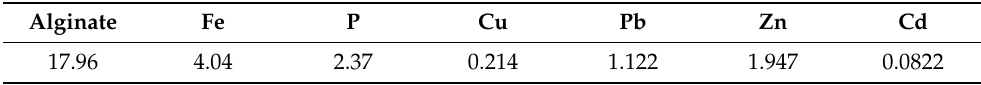
Table 1. The content (g/kg) of selected components of the AFP fertilizing preparation.